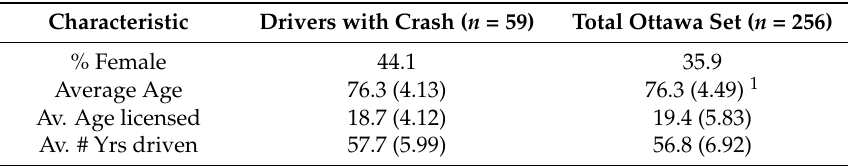
Table 1. Demographics of convenience sample of older drivers.